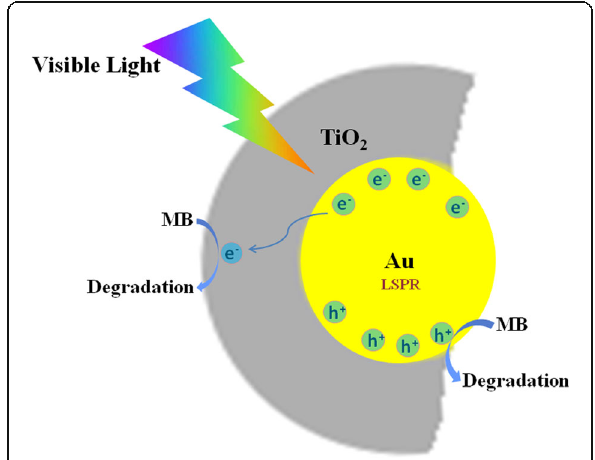
Fig. 7 Schematic representation for the mechanism of photocatalytic degradation of MB over Au@TiO 2